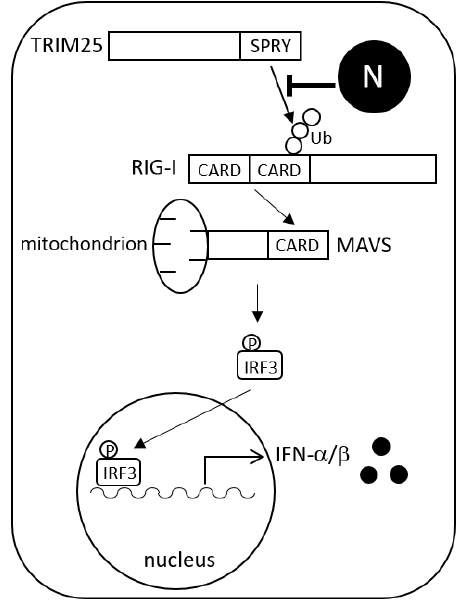
Figure 7. Models for inhibition of IFN production by HAZV N protein. N protein binds to TRIM25 to competitively inhibit the interaction between TRIM25 and RIG-I, resulting in the inhibition of K63-linked ubiquitination of RIG-I and subsequent type I IFN production.